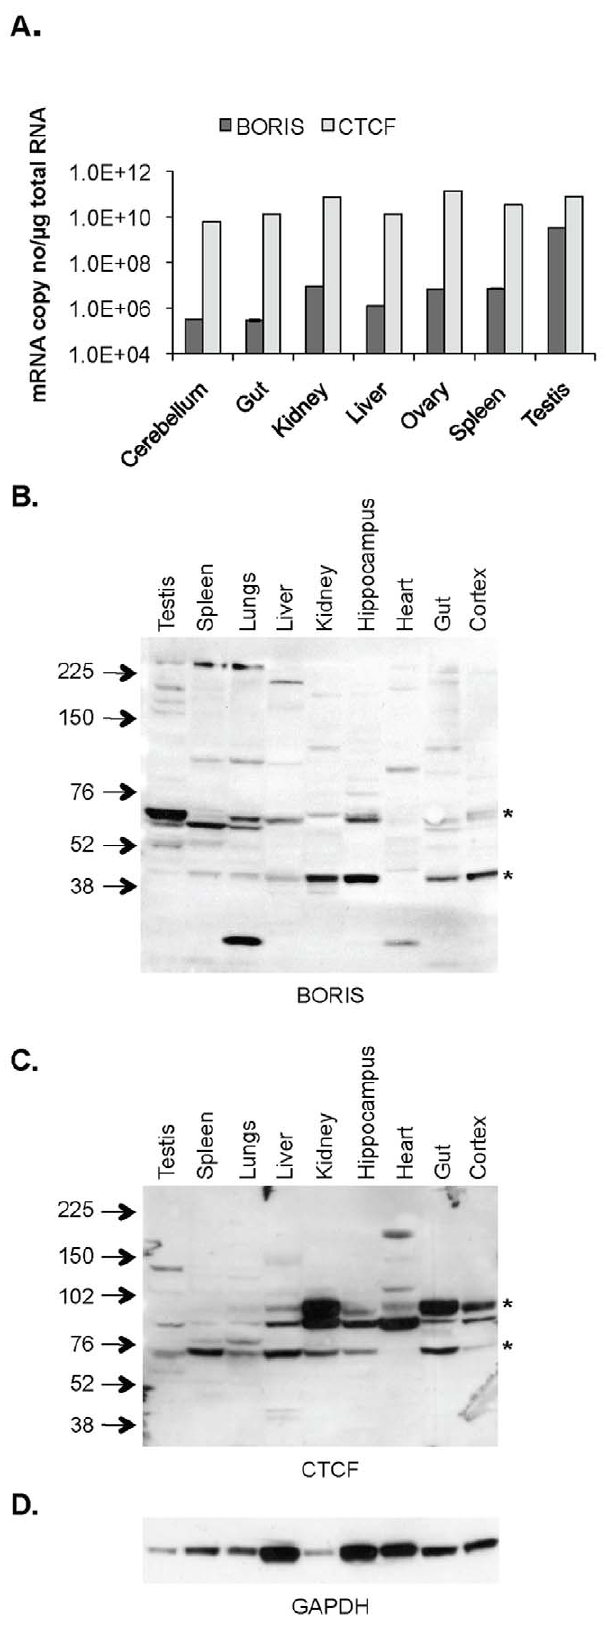
Figure 3. BORIS and CTCF expression in mouse tissues. A , BORIS and CTCF mRNA levels in selected normal mouse tissues. B , Western blotting for BORIS showing major bands (*) at 60–70 KDa and 45 KDa in mouse tissues. C , Western blotting for CTCF showing bands (*) between 70–100 KDa in mouse tissues. D , GAPDH was used as a control for loading differences. GE Healthcare Full Range Rainbow Marker, RPN800E, was used for determination of band size. Error bars in (A) represent the standard